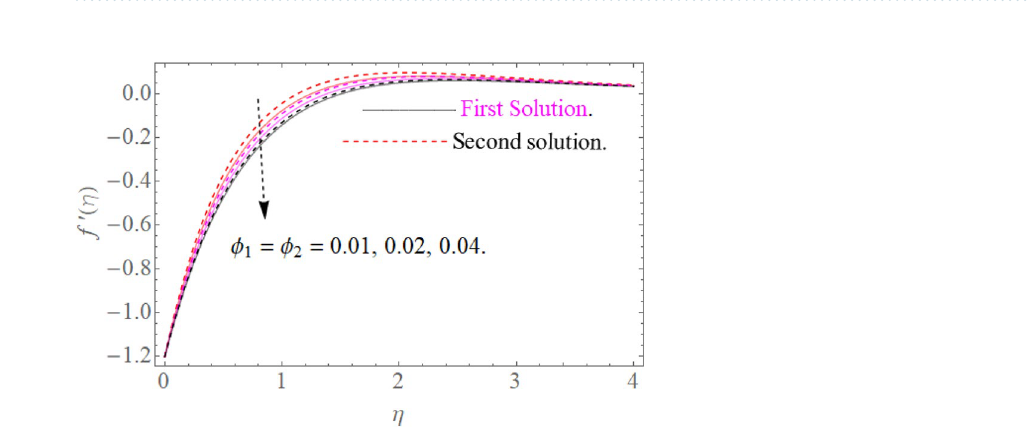
Figure 5. Influence of β on g (η) for M = 0.9, φ 2 = 0.02 .